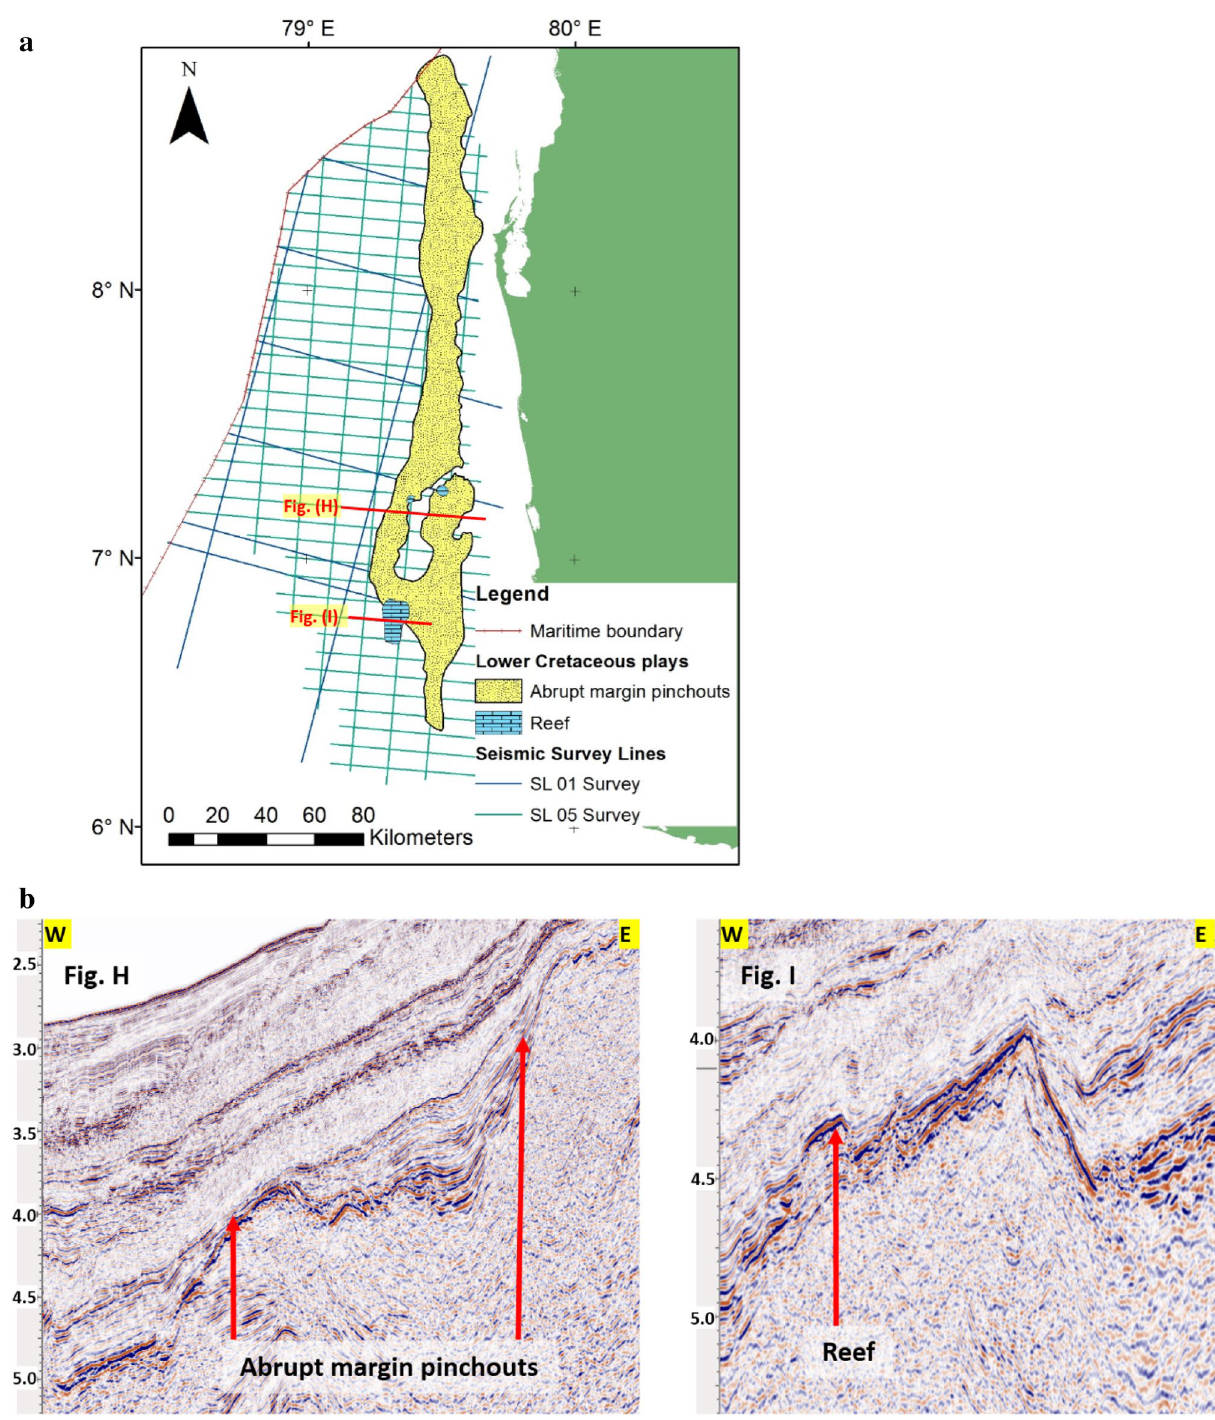
Fig. 12 a Map showing the distribution of the Lower Cretaceous plays in the Mannar Basin. b Seismic profiles showing potential plays in the Lower Cretaceous play level, (H) abrupt margin pinchouts, (I)